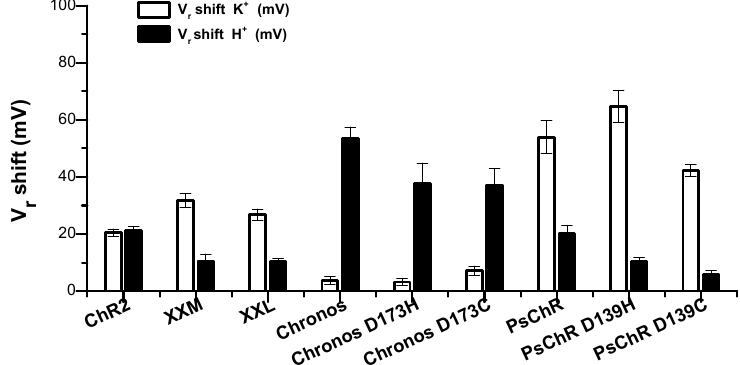
Figure 4. Comparison of K + and H + permeabilities of ChR2, Chronos, Ps ChR, and their mutants. 223